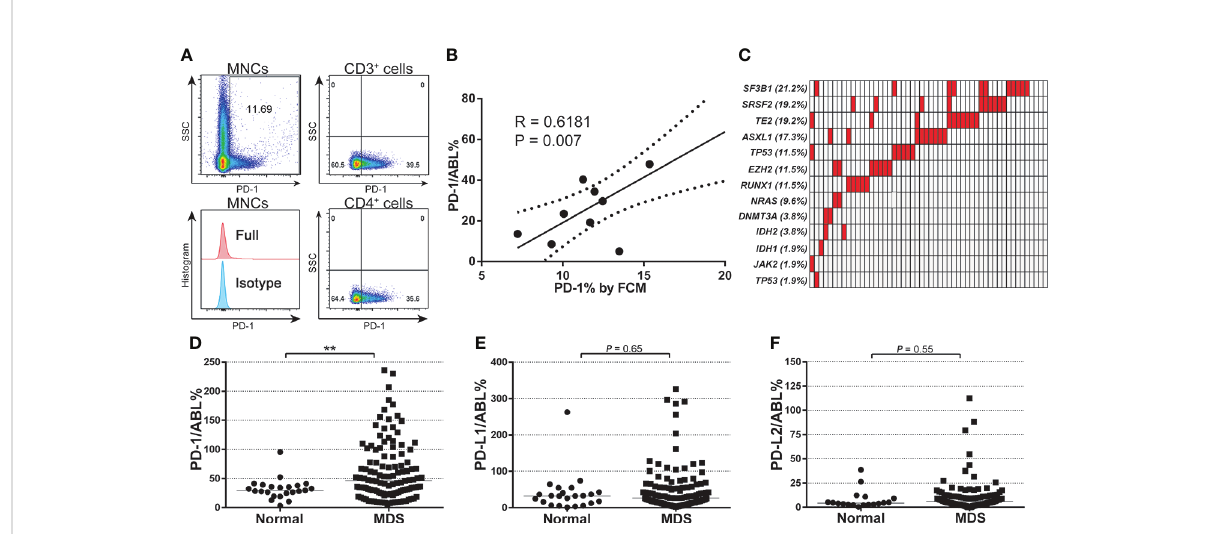
FIGURE 1 Baseline expression of PD-1, PD-L1, PD-L2, and mutational characteristics of MDS patients. (A) FCM detection for the expression of PD-1 protein in each gated cell subset in BM-MNC samples from patients with MDS (n=9). (B) Pearson analysis between the PD-1 gene expression (qPCR value) and protein levels in patients with MDS (n=9, R = 0.6181, P = 0.007). (C) Mutational pro fi le of a 13-gene panel of hotspot mutations (Supplemental Table 3) in MDS patients (n=52). (D) Normalized baseline expression of PD-1 in the bone marrow samples from normal individuals (n=23) and MDS patients (n=102). (E) Normalized baseline expression of PD-L1 in the bone marrow samples from normal individuals (n=23) and MDS patients (n=102). (F) Normalized baseline expression of PD-L2 in the bone marrow samples from normal individuals (n=18) and MDS patients (n=102). Results were presented as mean ± SEM of independent cases. *P < 0.05. **P < 0.01. ***P <